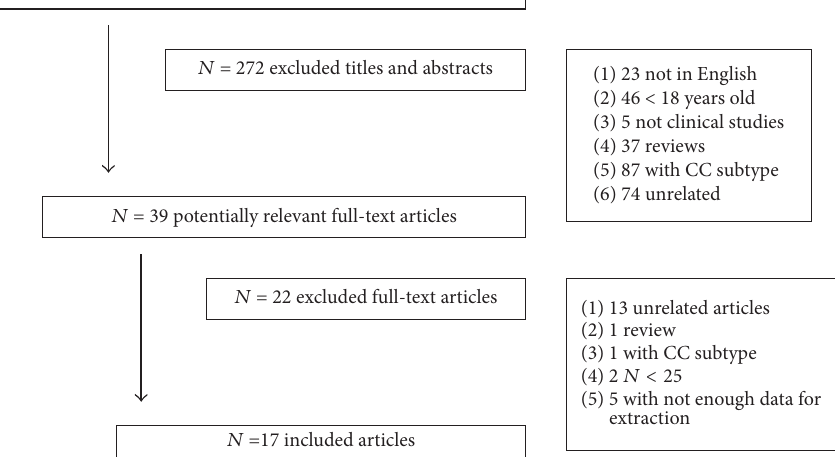
Figure 1: Flowchart of the literature search and study selection process.